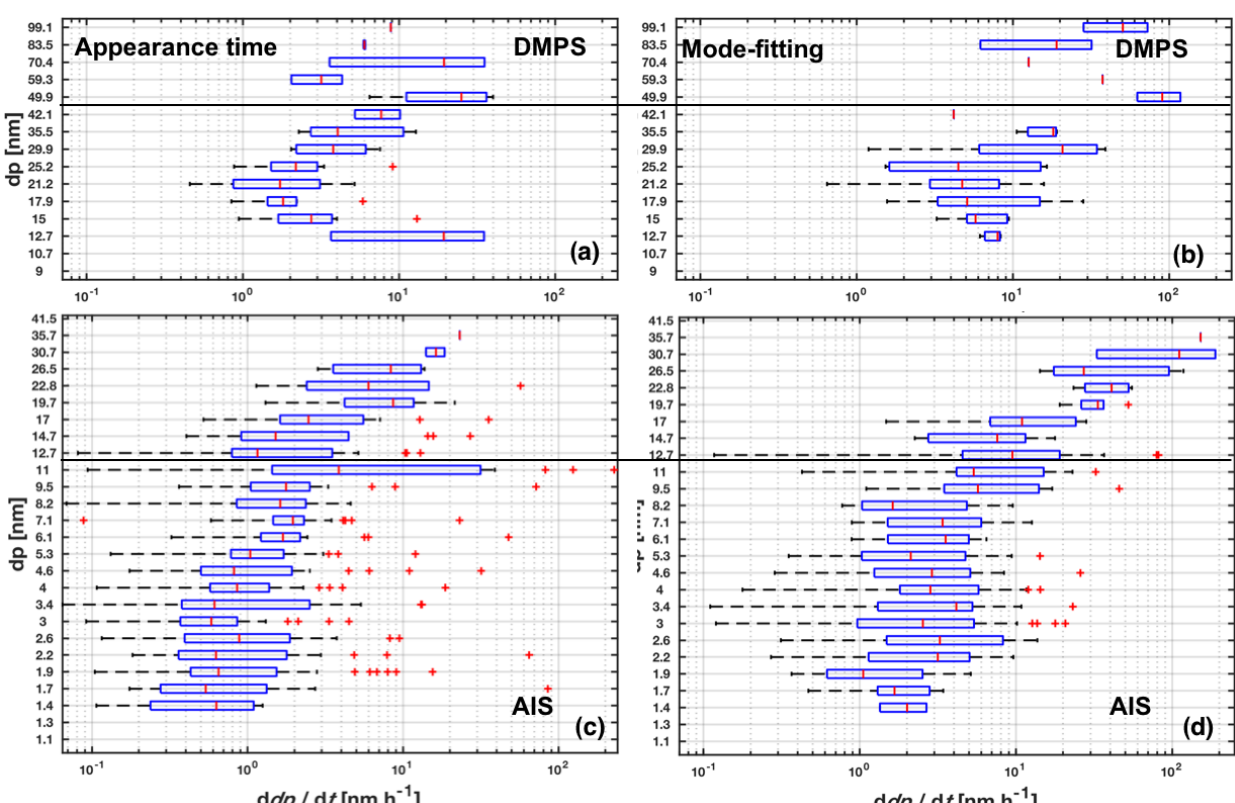
Figure 6. The GR dependence on size. Sizes are in mobility diameters and GRs of ions and particles are presented as discrete time derivatives of the change in mobility diameters (d dp/ d t ). GRs of aerosol particles measured by the DMPS are shown in the upper panels (a, b) , and GRs of ions measured by the AIS are shown in the lower panels (c, d) . GRs in the left-hand panels (a, c) are determined using the appearance time method and those in the right-hand panels (b, d) are determined using the mode-fitting method. The solid black lines indicate the overlapping size range of the DMPS and AIS measurements. The box was drawn with 25th and 75th percentiles of GRs determined at each size, with the median indicated as a right bar inside the box. The whiskers extend to the smallest and highest GR values within 1.5 times the interquartile range at each size. GRs beyond the 1.5 times interquartile range are marked by red crosses as